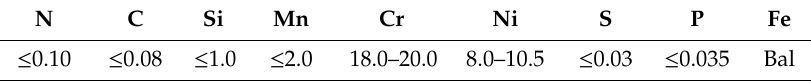
Table 2. Basic properties of 304 stainless steel used in this study.